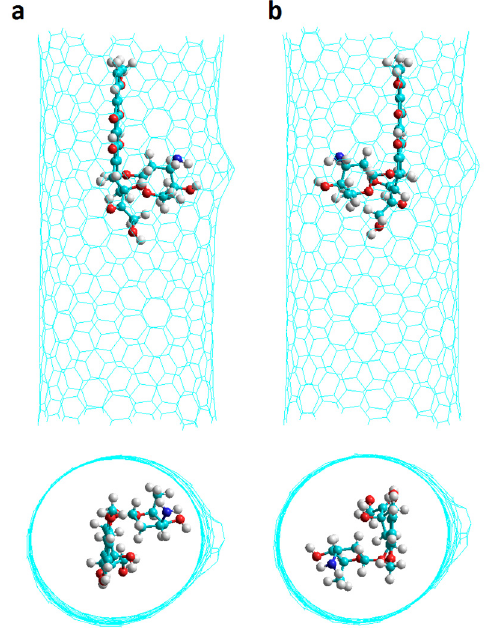
Figure 3. The encapsulated DOX orientations into a chiral nanotube having one haeckelite defect. ( a ) Hk1-DoxDIn.v1p; the DOX NH 2 group is oriented in a direction proximal to the defect; ( b ) Hk1-DoxDIn.v1o; the DOX NH 2 group is oriented in an opposite direction. Lateral and frontal views shown.